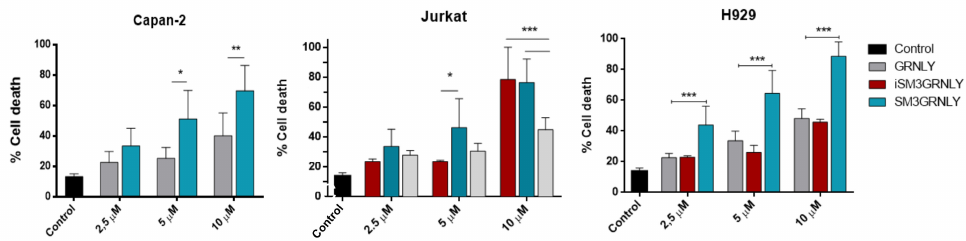
Figure 5. Dose-response cytotoxicity assays of GRNLY, SM3GRNLY and iSM3GRNLY on Capna-2, Jurkat and H929 cells. The cells were incubated with increasing concentrations of the recombinant proteins GRNLY (gray bars), iSM3GRNLY (red bars) or SM3GRNLY (green bars) for 24 h. GRNLY, SM3GRNLY and iSM3GRNLY induced cell death was determined by detection of PS translocation by Annexin-V-FITC labeling combined with size analysis. Results are the mean ± SD of at least three different experiments performed in triplicate. * p < 0.05, ** p < 0.01, *** p <